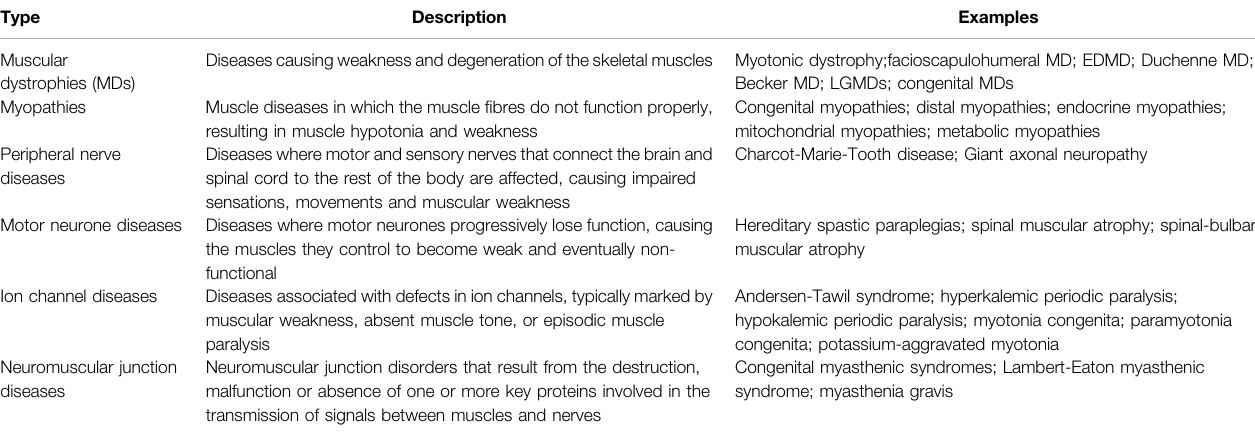
TABLE 1 | Classi fi cation of NMDs including some